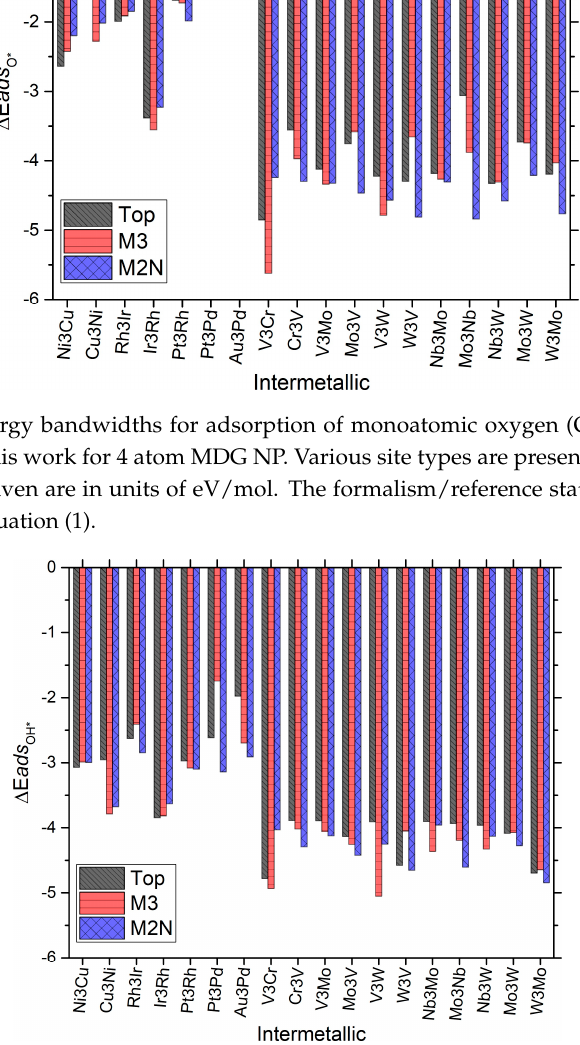
Figure 3. Plot of energy bandwidths for adsorption of hydroxyl (OH*) on the candidate systems studied in this work for 4 atom MDG NP. Various site types are presented in each set of the columns. Energies given are in units of eV/mol. The formalism /reference state for calculating the energy is analogous to that given in Equation 1 for O*.